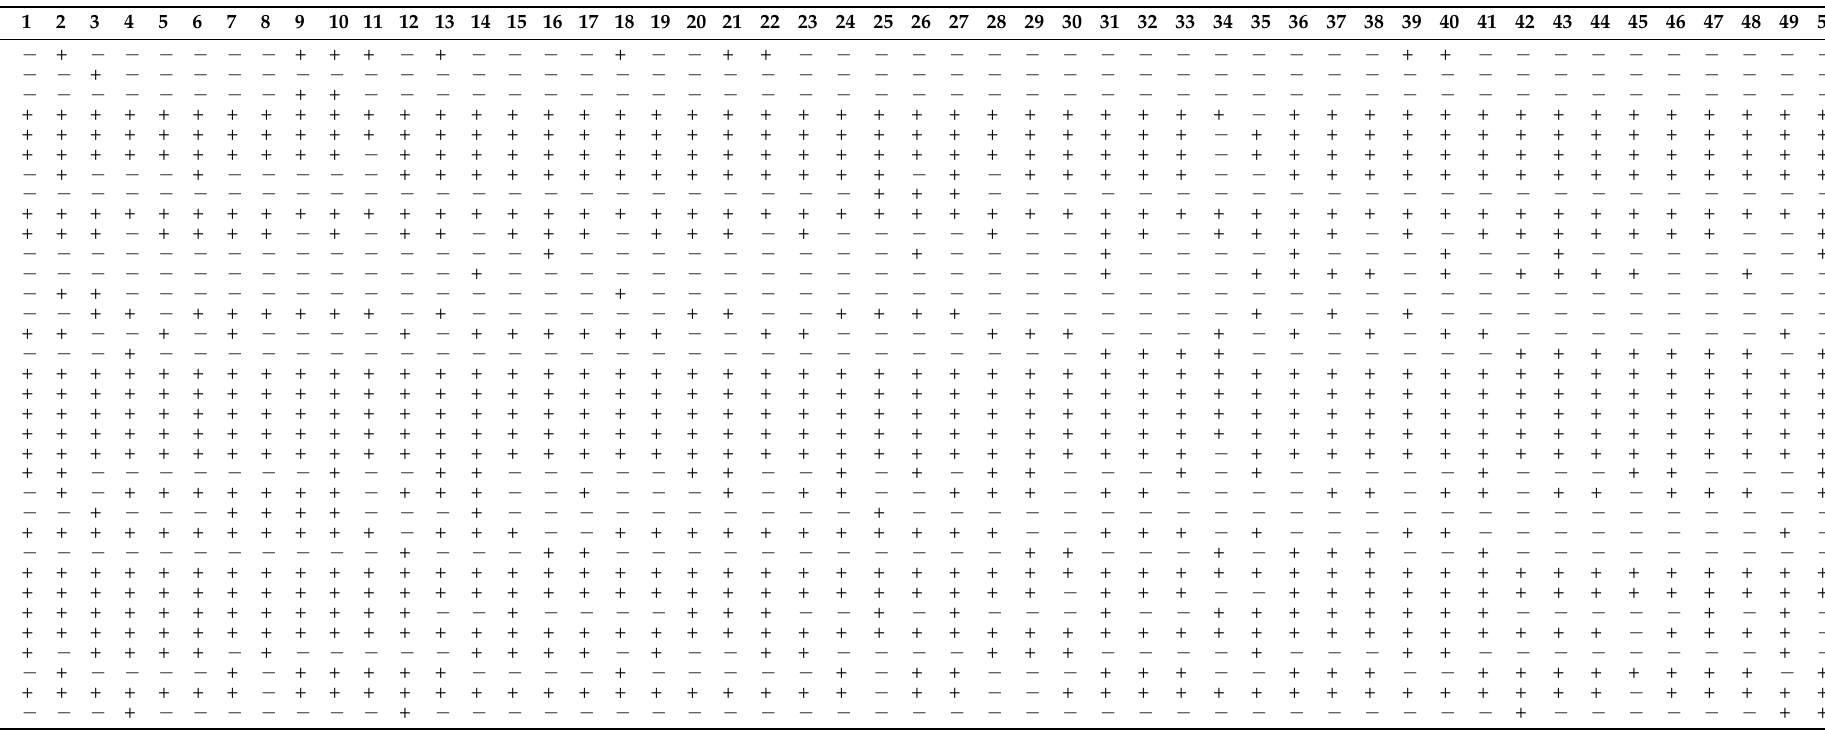
Table 4. Presence and absence of leaf rust resistant genes/alleles within the genetic makeup of the 50 Egyptian wheat